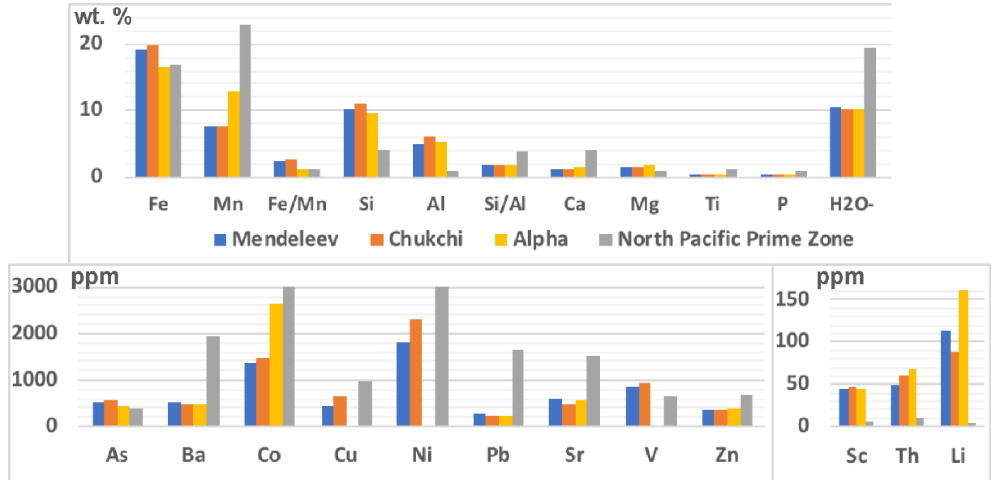
Figure 1. Chemical composition of crusts from Mendeleev Ridge, Chukchi Borderland, and Alpha Ridge (Arctic Ocean) compared to crusts from Pacific Prime Crust Zone [1,3].